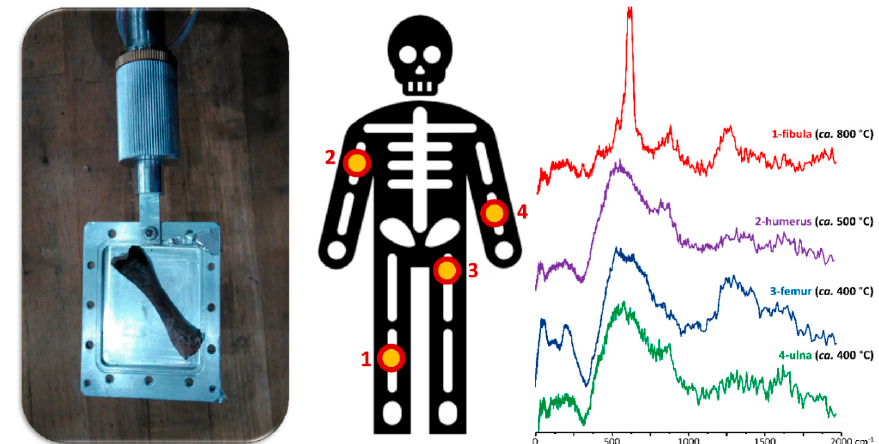
Figure 7. ( Left ) human bone in the sample holder; middle: location in the skeleton of the bones studied; and ( Right ) vibrational spectra of samples coming from this same skeleton (Leopoli-Cencelle, Italy), over a wide range of firing temperatures (400 °C to 800 °C) [57,82].